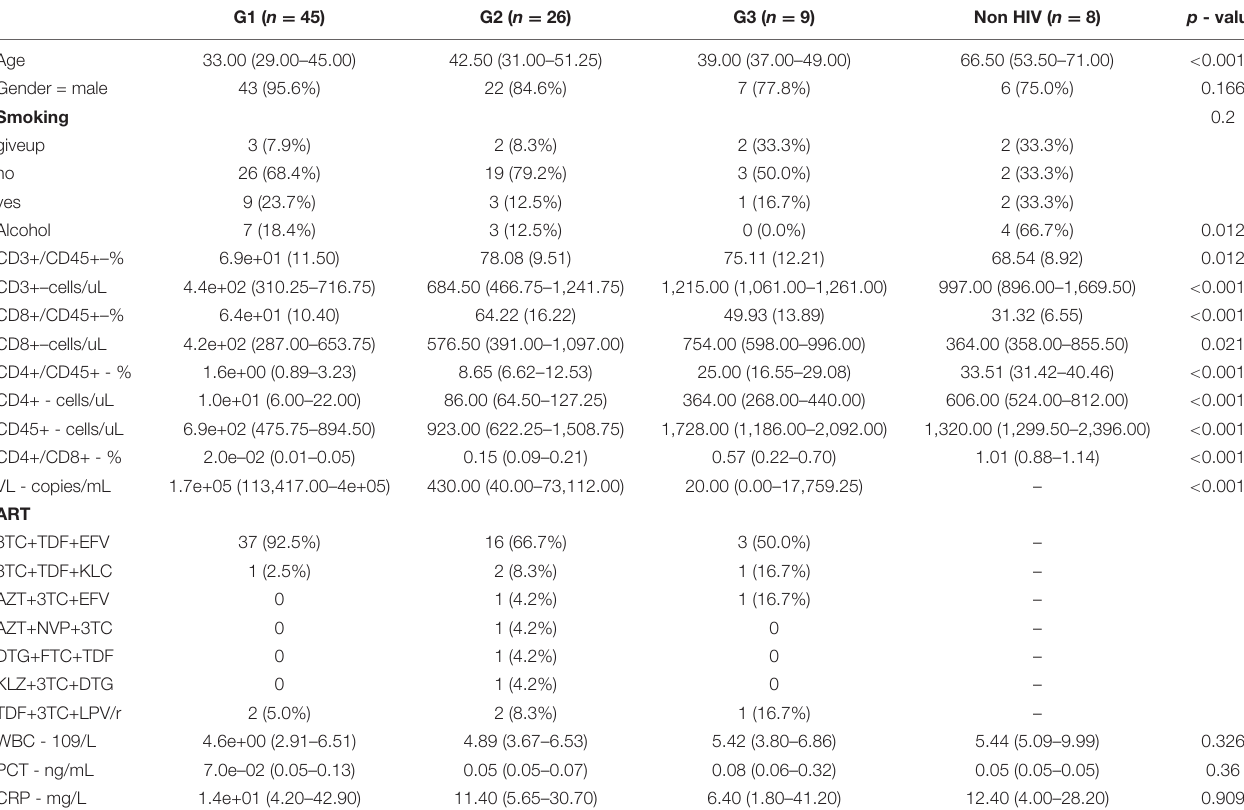
TABLE 1 | Clinical features of